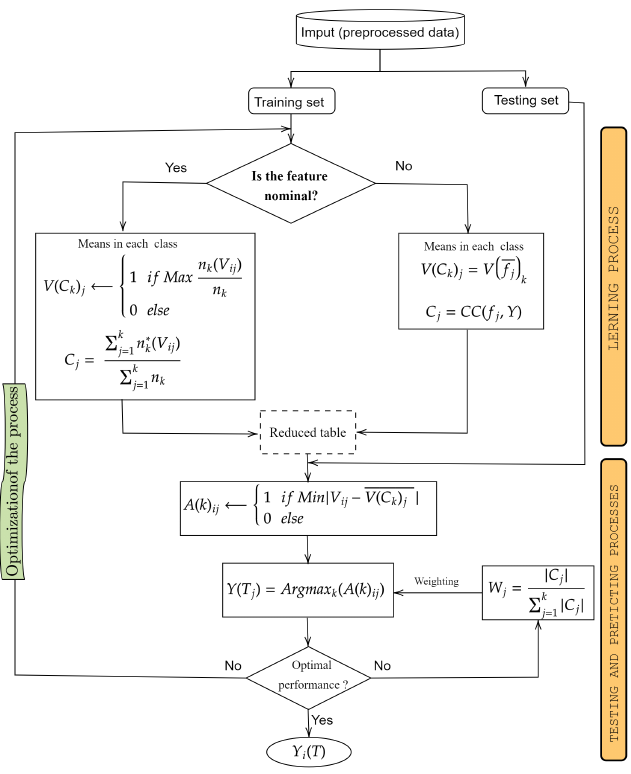
Figure 2. Flowchart of the classification steps of the CMB